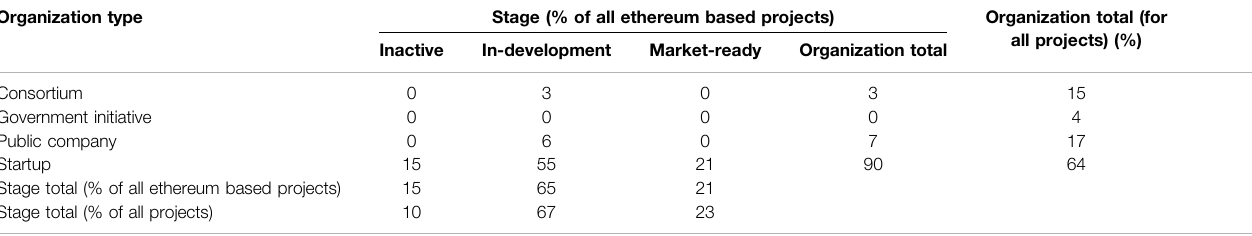
Organization type